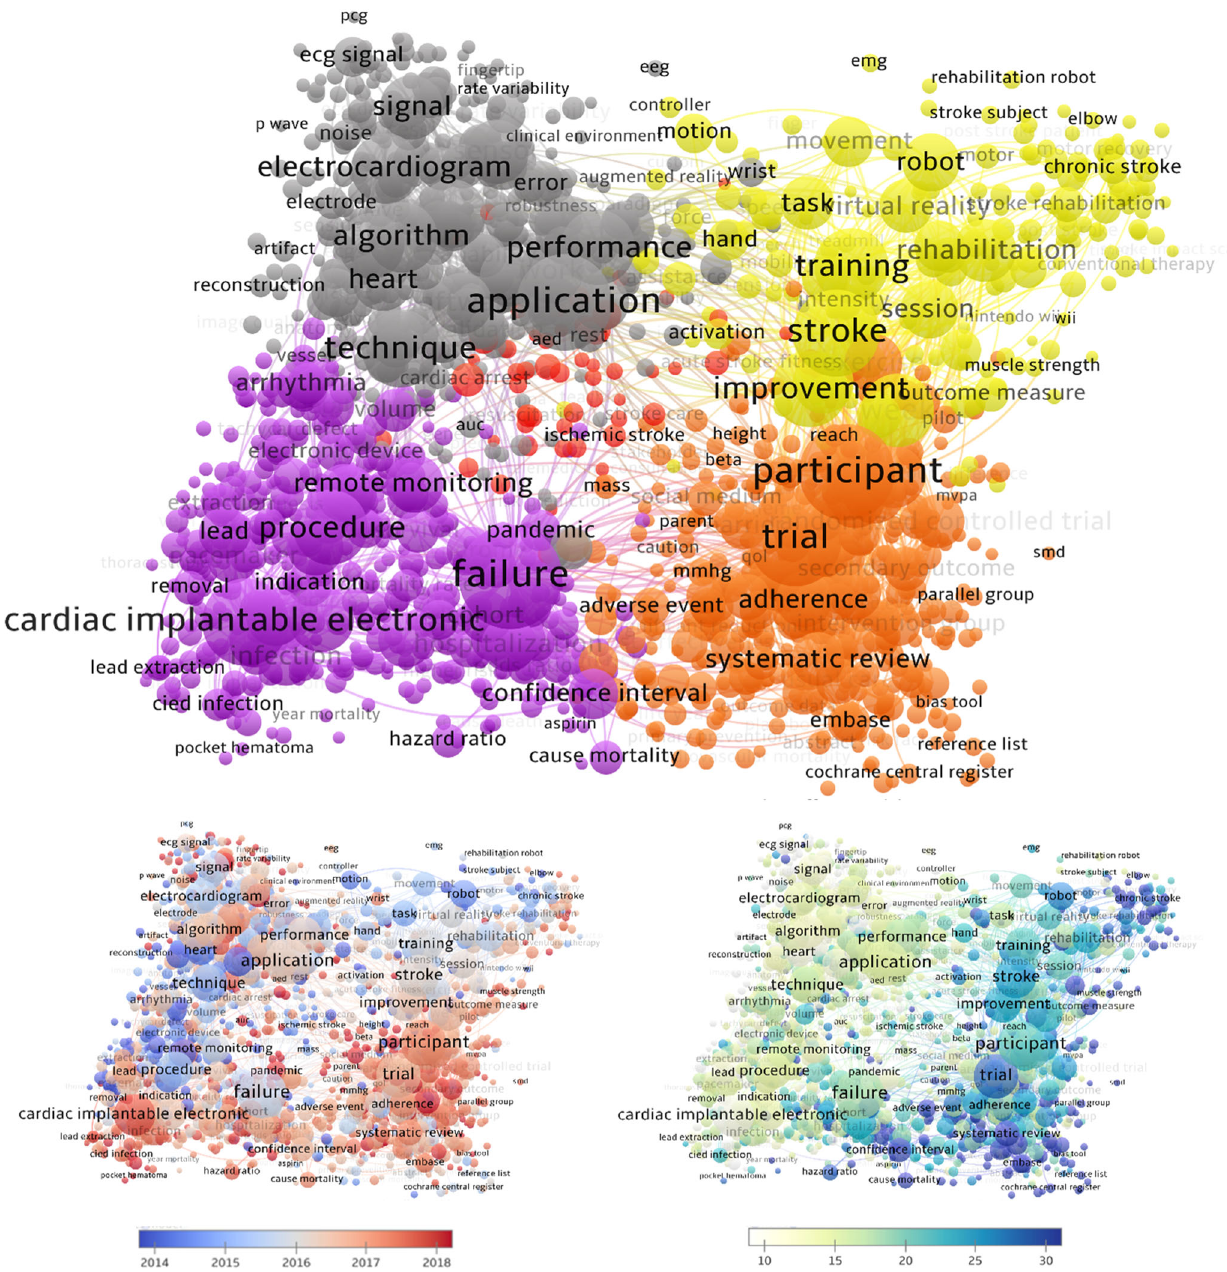
Fig. 3 Network-view map of term co-occurrence in titles and abstracts of articles within digital health technologies in cardiovascular medicine. Bottom left: map of average publication year; Bottom right: map of average number of citations. An interactive online map is available here: https://app.vosviewer.com/?json = https://drive.google.com/uc?id =